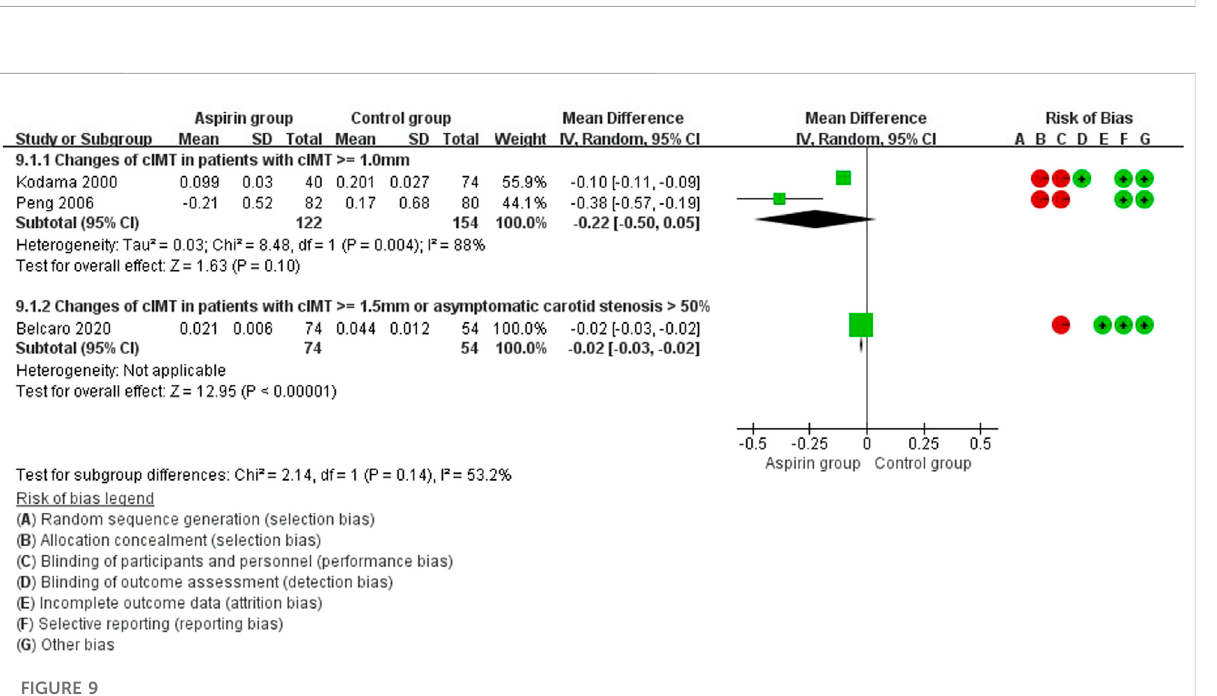
FIGURE 8 Forest plot of changes in carotid intima-media thickness (cIMT) between the aspirin group and the control group in type 2 diabetes mellitus.